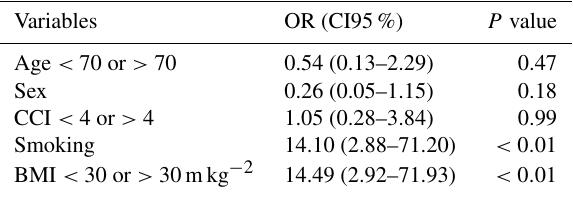
Table 6. Univariate logistic regression of risk factors for failure.